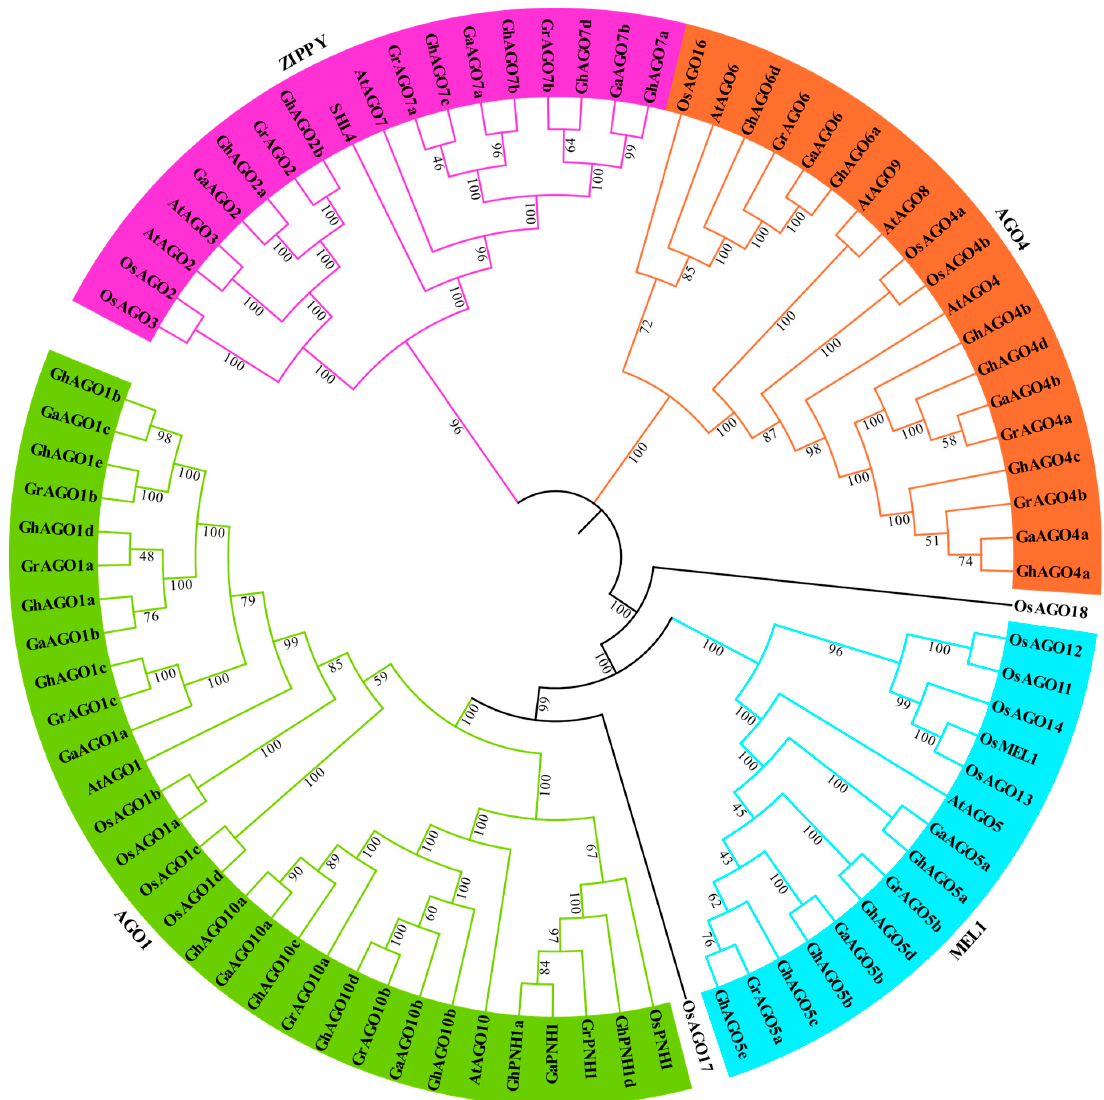
Figure 1. Phylogenetic tree of the Gossypium AGO proteins. The AGO protein sequences of Gossypium, Arabidopsis, and rice were aligned using ClustalW. The MEGA 11 program was used to generate the NJ tree with 1000 bootstrap replicates. Different subgroups of AGO proteins are highlighted with various colors.